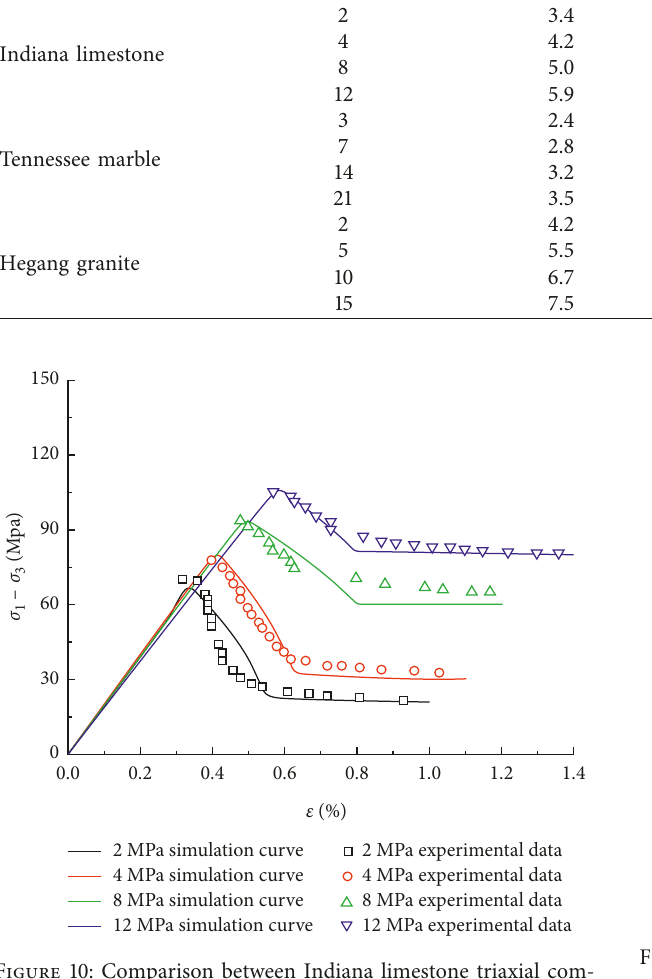
Table 3: Rock strength parameters ( m,s ) of different rock types at the peak position and at the starting point of the residual stage. Rock type